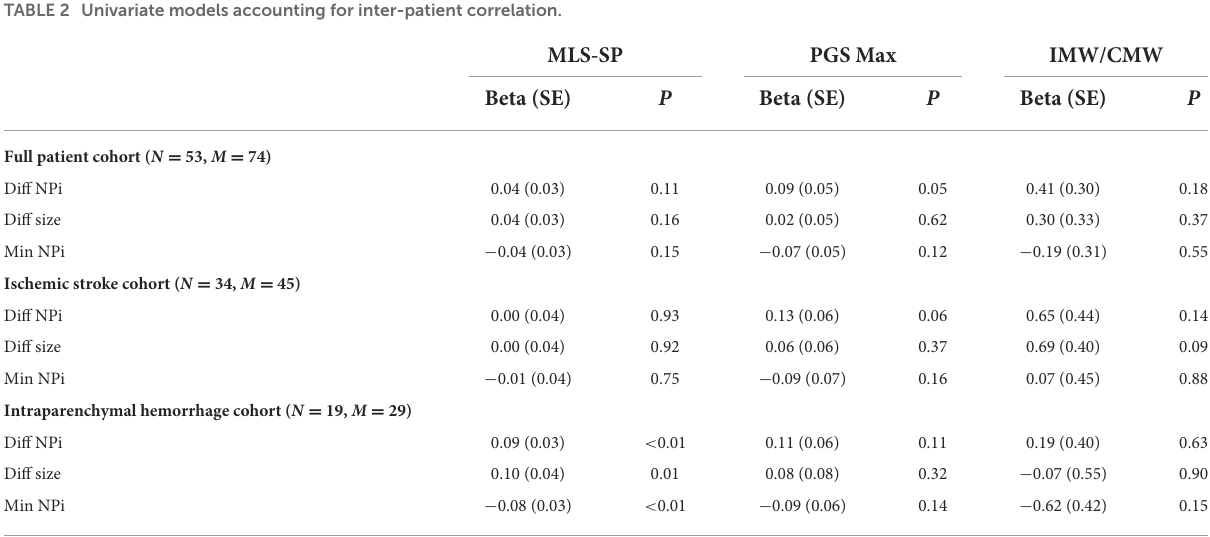
TABLE 2 Univariate models accounting for inter-patient